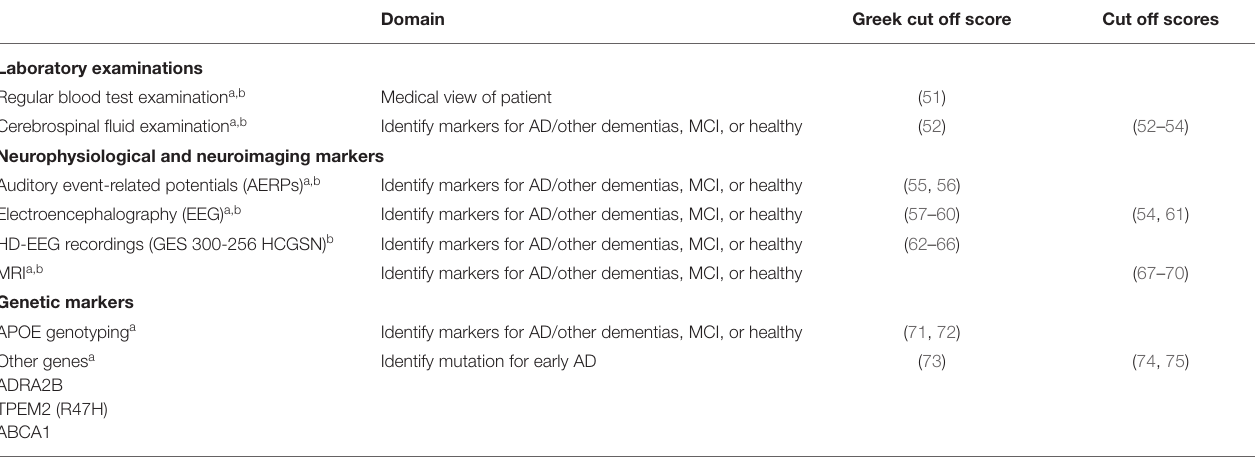
TABLE 3 | Further examinations (neurochemical and